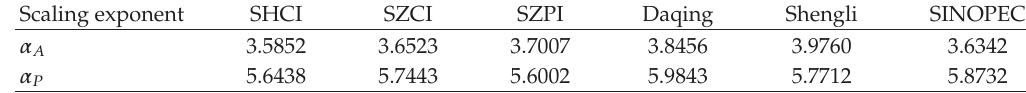
Table 6: Scaling exponent of the absolute